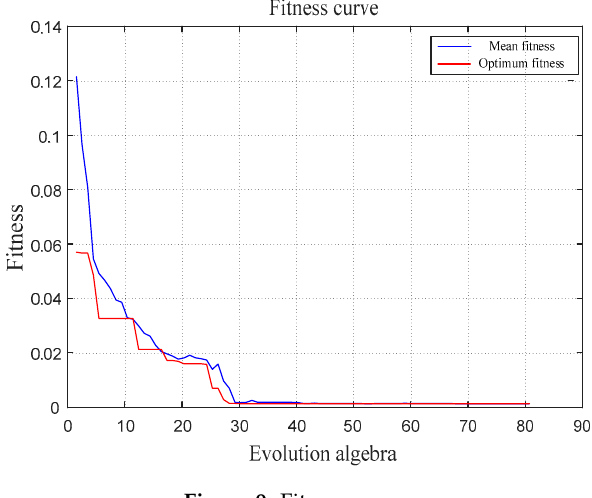
Figure 9. Fitness curve.